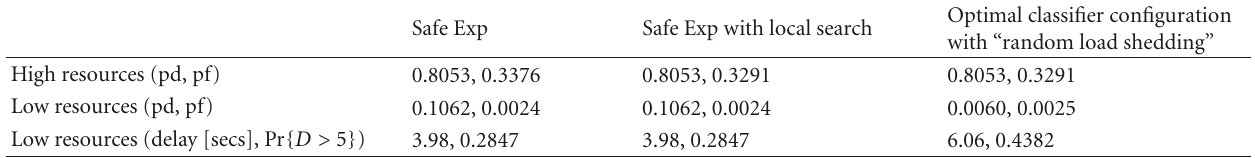
Table 2: Detection and false alarm tradeo ff for the entire chain after global convergence of